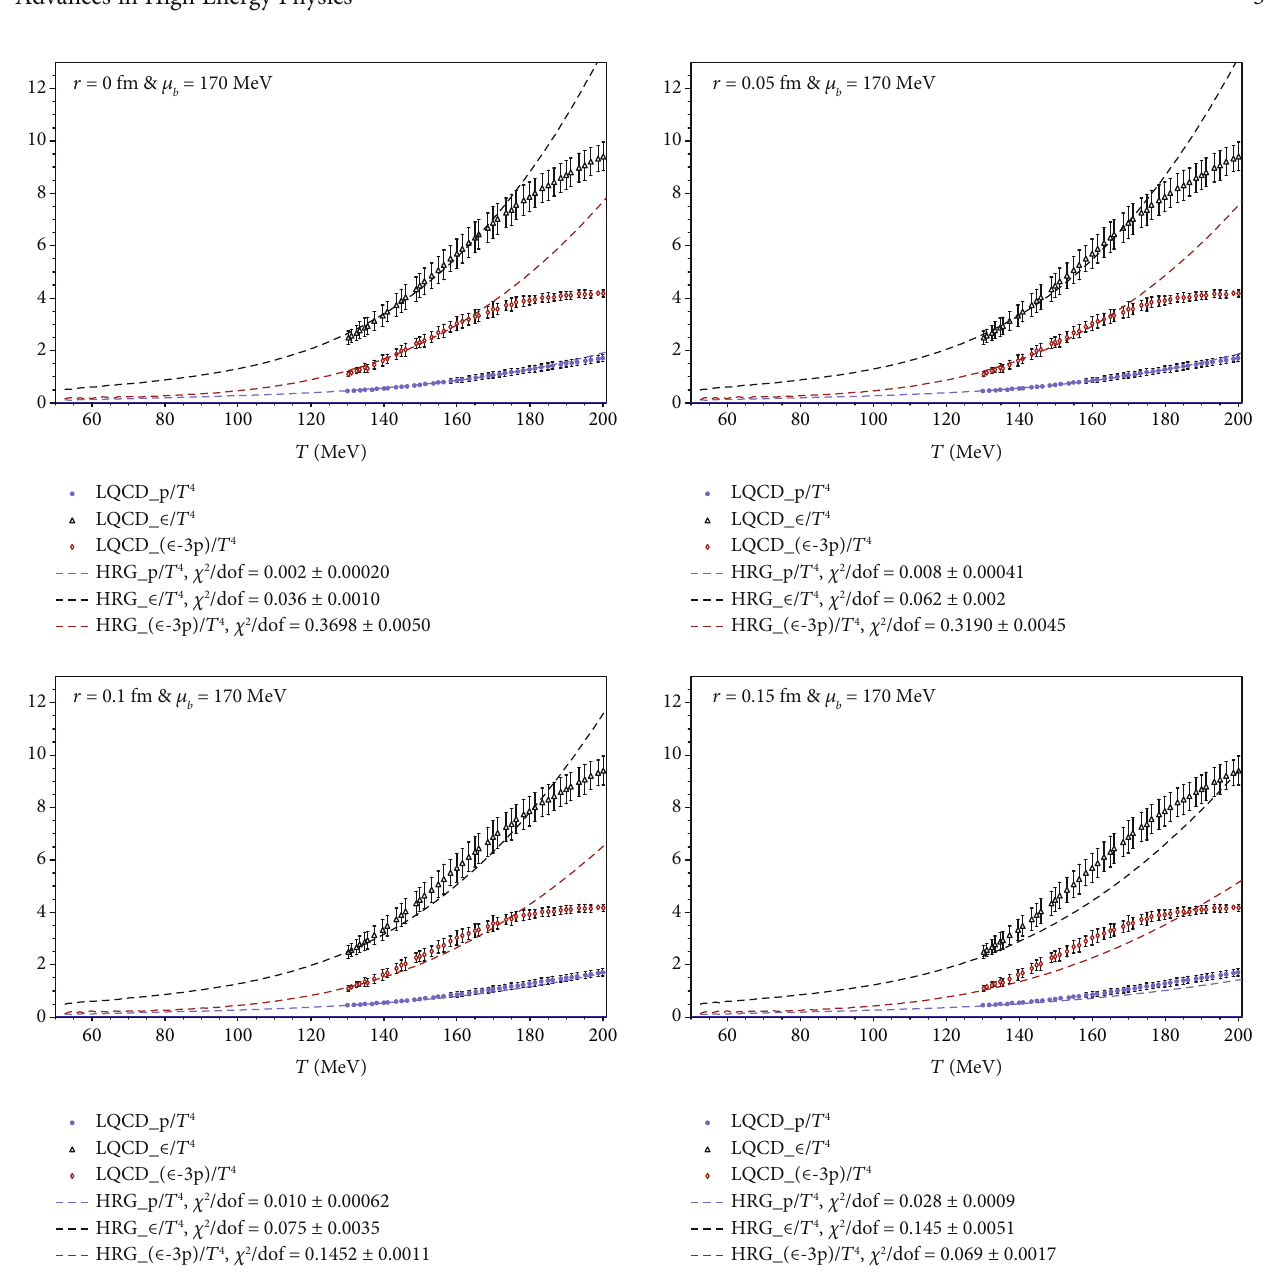
Figure 2: The same as in Figure 1 but at μ